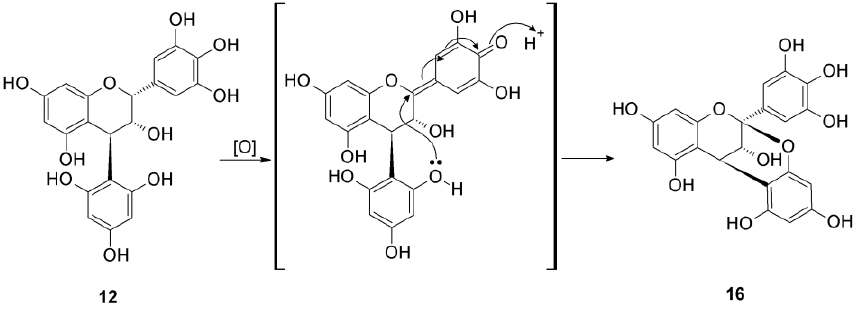
Scheme 3. Formation of 16 by oxidative hydride abstraction.